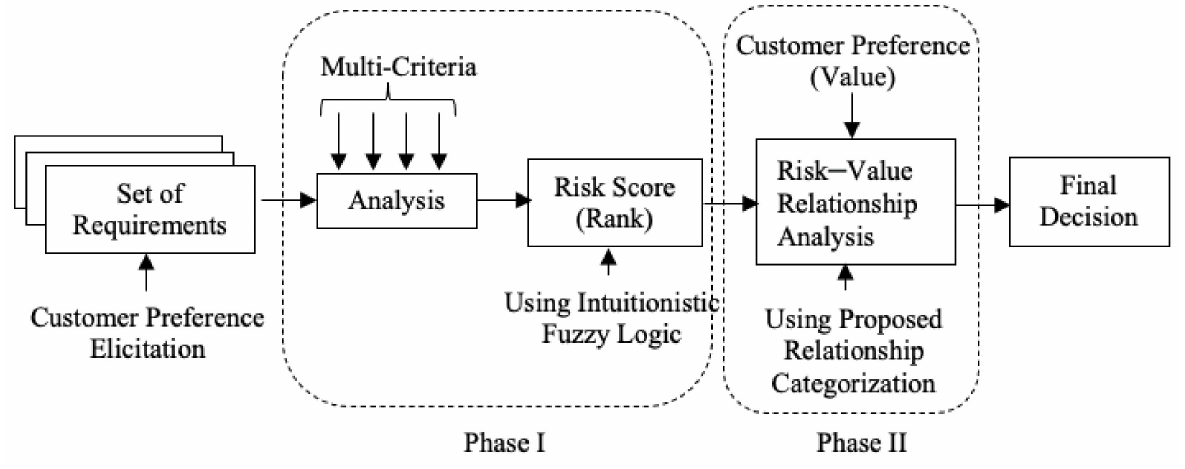
Figure 1. Basic steps in the proposed risk assessment